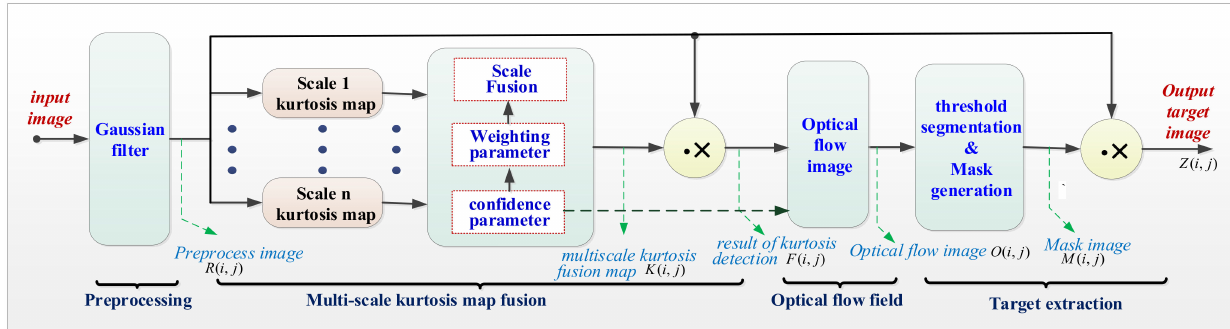
Figure 2. The framework of the presented